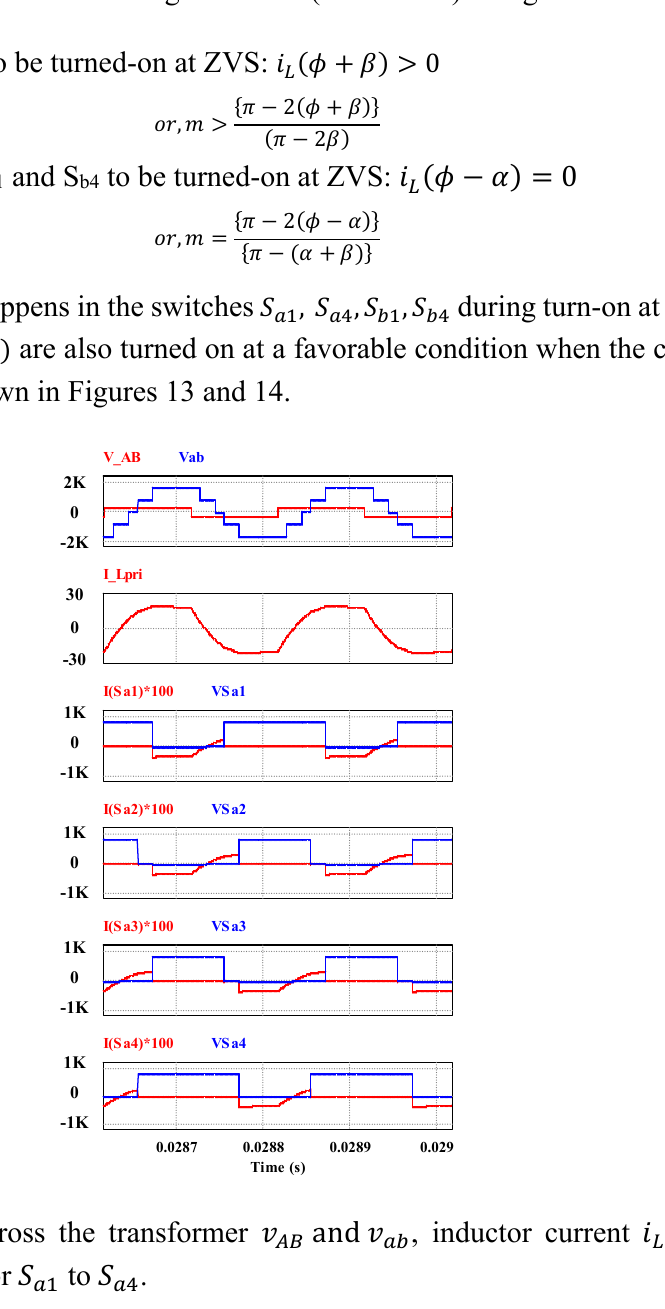
to (cid:1845) (cid:3028)(cid:2869) (cid:3028)(cid:2872)